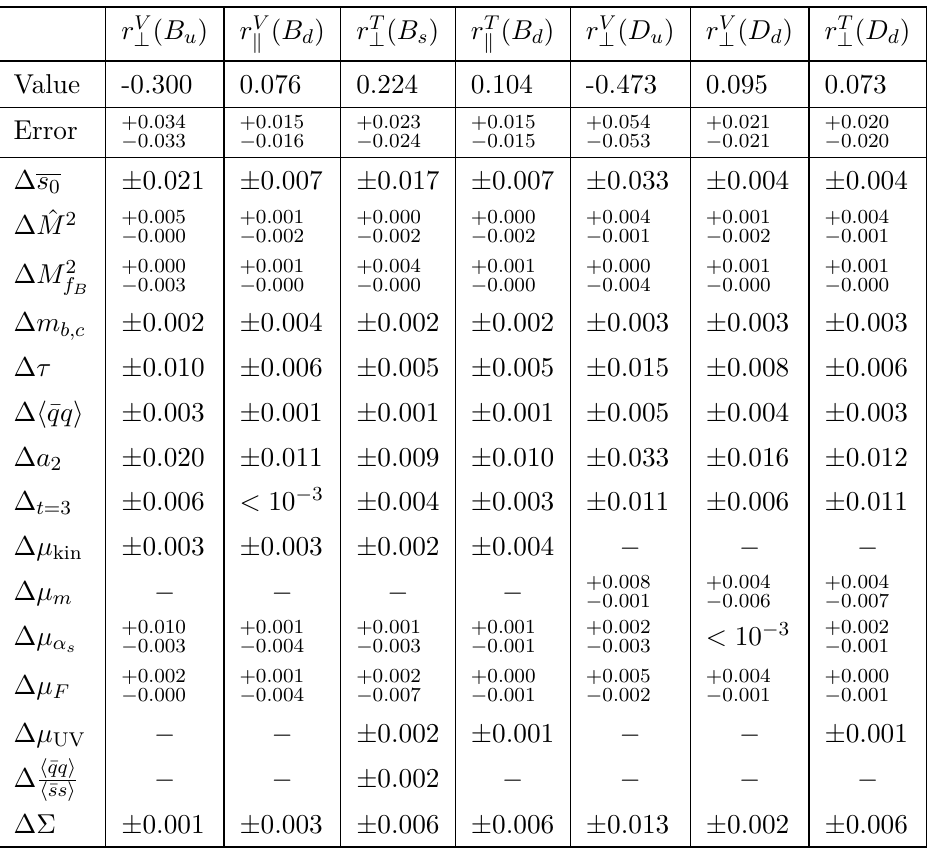
Table 4 . Breakdown of the main contributions to the uncertainty for a representative selection of residues. ∆ s 0 includes the combined uncertainty, incorporating correlations, due varying all effective thresholds, cf. discussion above (3.1). ∆ t =3 contains the total uncertainty due to all twist- 3 hadronic parameters { f 3 γ , ω A , ω V } . The uncertainty due to the choice of duality region is encapsulated in the γ γ quantity ∆Σ which represents the standard deviation of the a = { 1 / 2 , 1 , 2 } evaluations. The total uncertainty, which also includes smaller contributions such as the gluon condensate, is obtained by added uncertainties in quadrature.